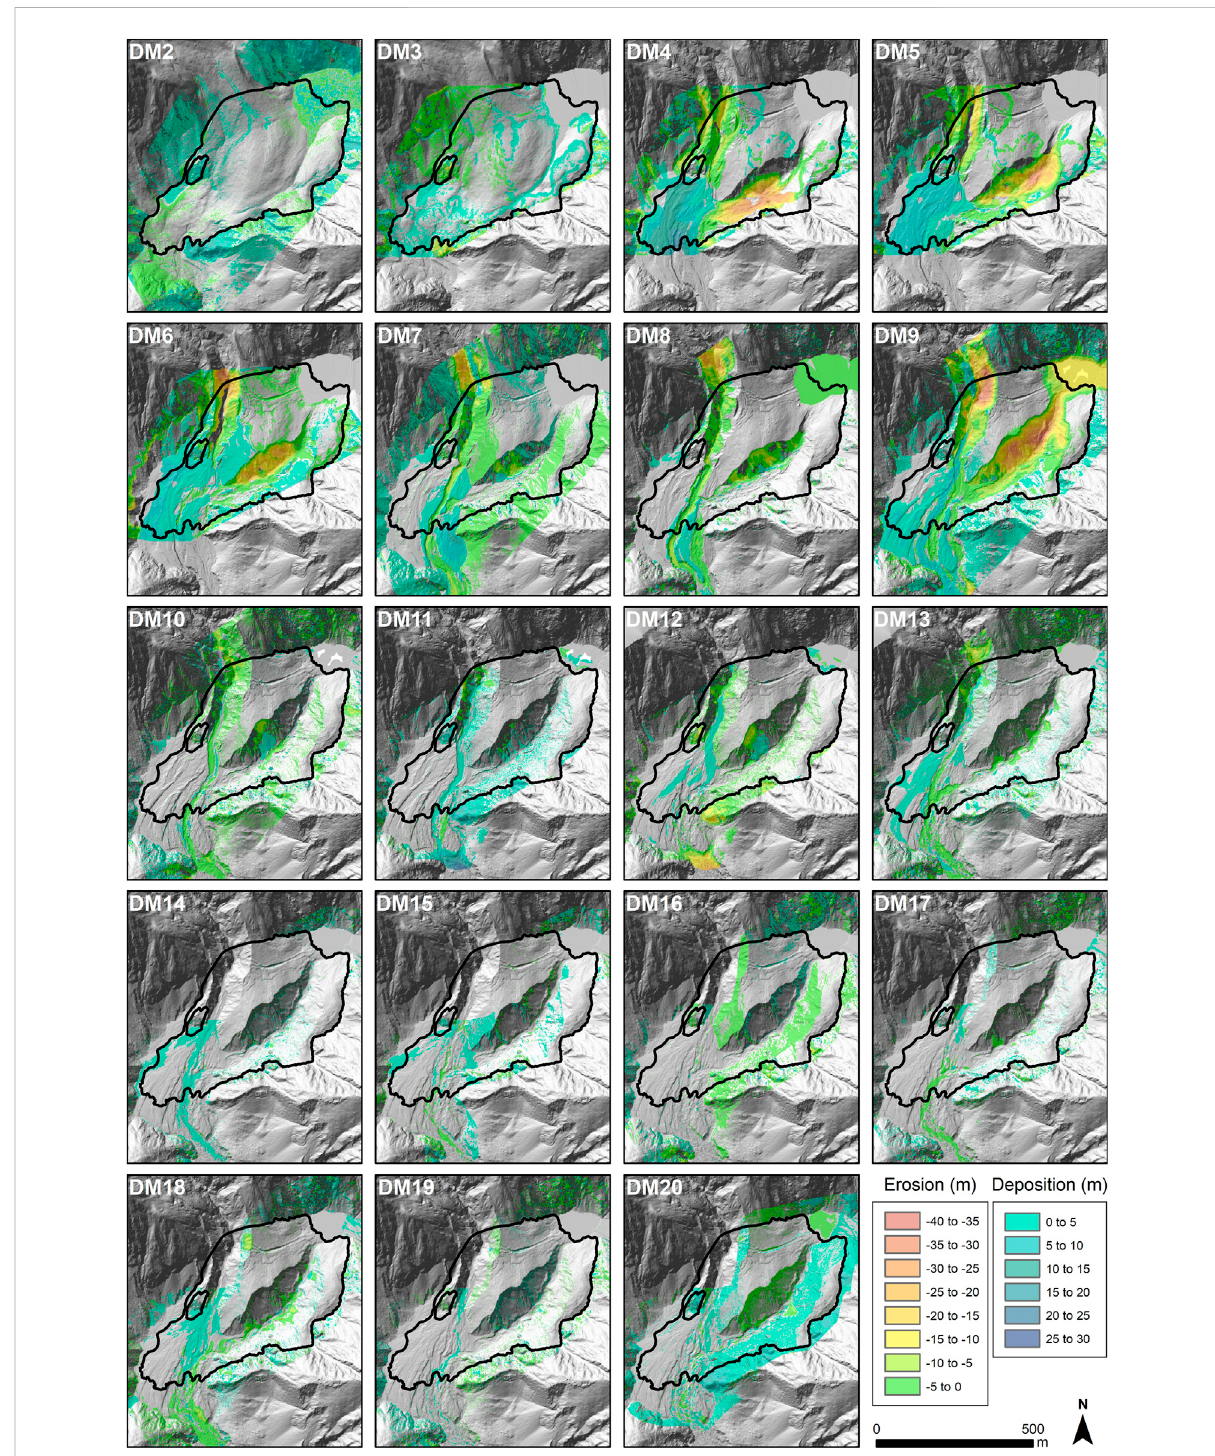
FIGURE 8 2D differencing of all epochs post emplacement (DM = difference model number). See Table 1 for details. Base data are: 2016 epoch 2 LiDAR DEM (DM2-3), 2017 epoch 7 LiDAR DEM (DM4-6), 2018 epoch 8 LiDAR DEM (DM7), 2018 epoch 9 LiDAR DEM (DM8), 2019 epoch 11 LiDAR DEM (DM9-11), 2020 epoch 14 LiDAR DEM (DM12-13), and 2021 epoch 16 LiDAR DEM